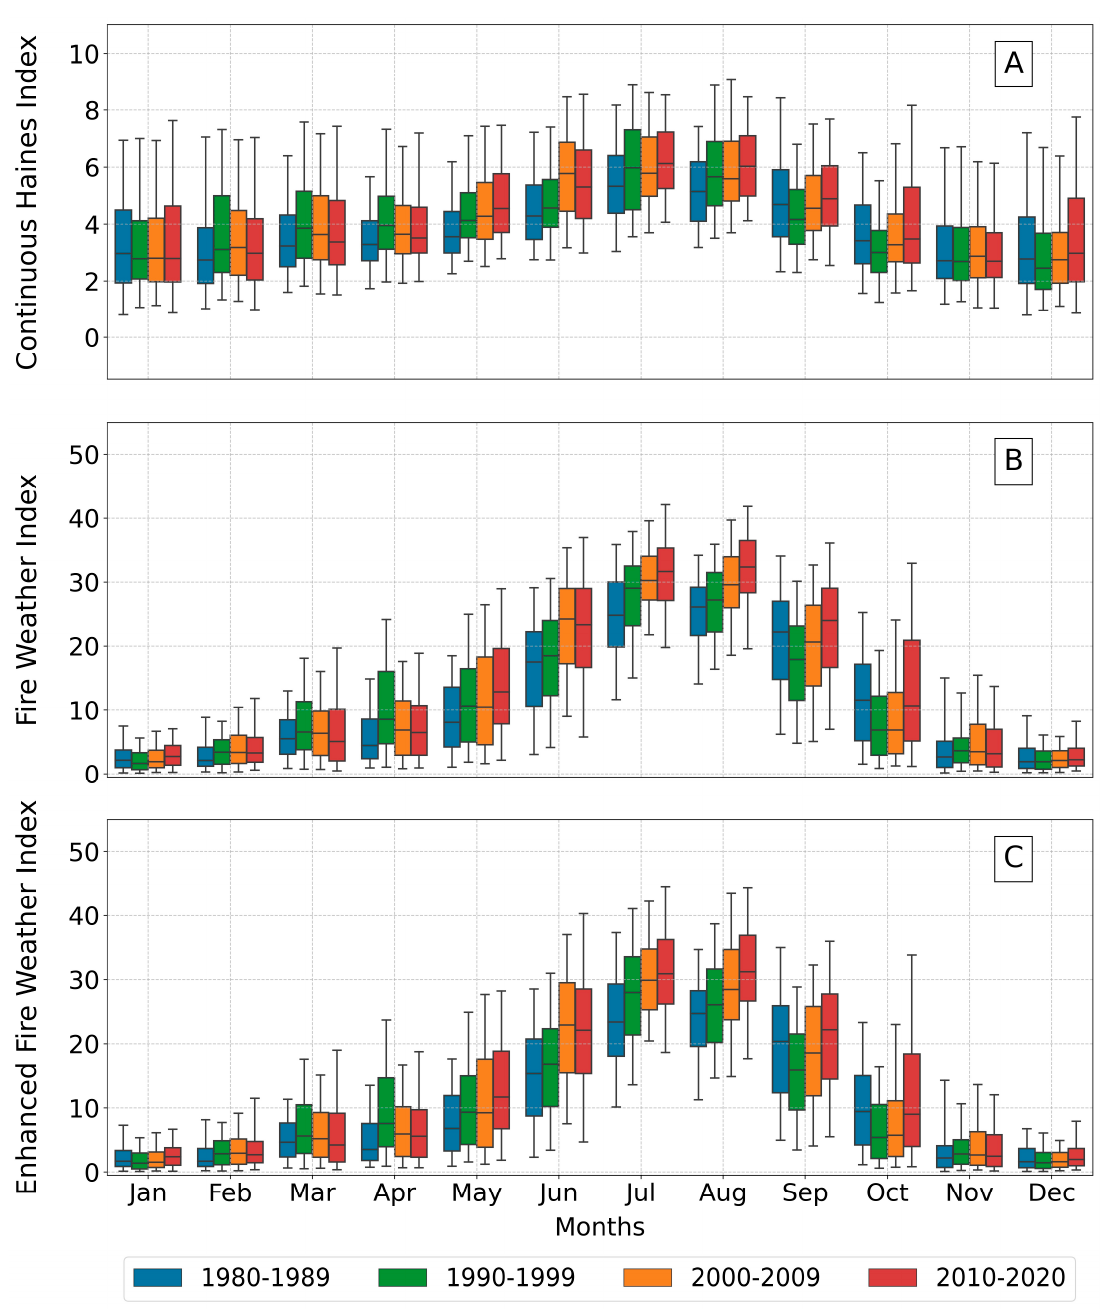
Figure 4. Boxplots showing evolution of the yearly distribution in the IP average throughout the decades of the 1980–2020 period for the variables ( A ) CHI, ( B ) FWI, and ( C ) FWIe.